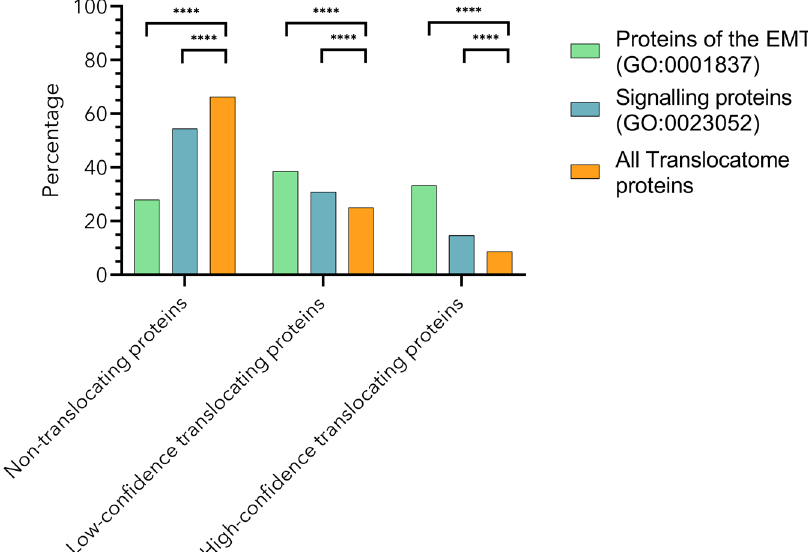
Fig. 1 Translocating proteins are enriched between signalling and EMT proteins. On this fi gure, we can see the distribution of proteins according to their translocation probability in different datasets (Translocatome proteins, Signalling proteins and EMT proteins, see Methods for details). There were signi fi cantly more high-con fi dence translocating proteins between the Signalling (15%) and EMT (33%) proteins than between the Translocatome proteins (9%). We can observe the same signi fi cant difference in the case of low-con fi dence translocating proteins. The percentage of low-con fi dence translocating proteins is higher between Signalling (31%) and EMT proteins (39%) than between Translocatome proteins (25%). Oppositely in the case of non-translocating proteins there is a lower percentage of non-translocating proteins between signalling (54%) and EMT (28%) proteins than between Translocatome proteins (66%). For further details about the calculation of protein enrichment refer to the Methods section, and to understand the details of the Translocatome data please refer to its original publication 5 . **** p < 0.0001, Chi-square